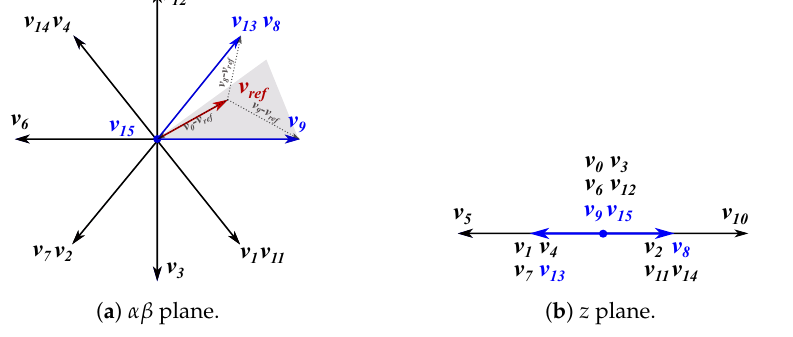
Figure 5. Complete fault-operation space vector.